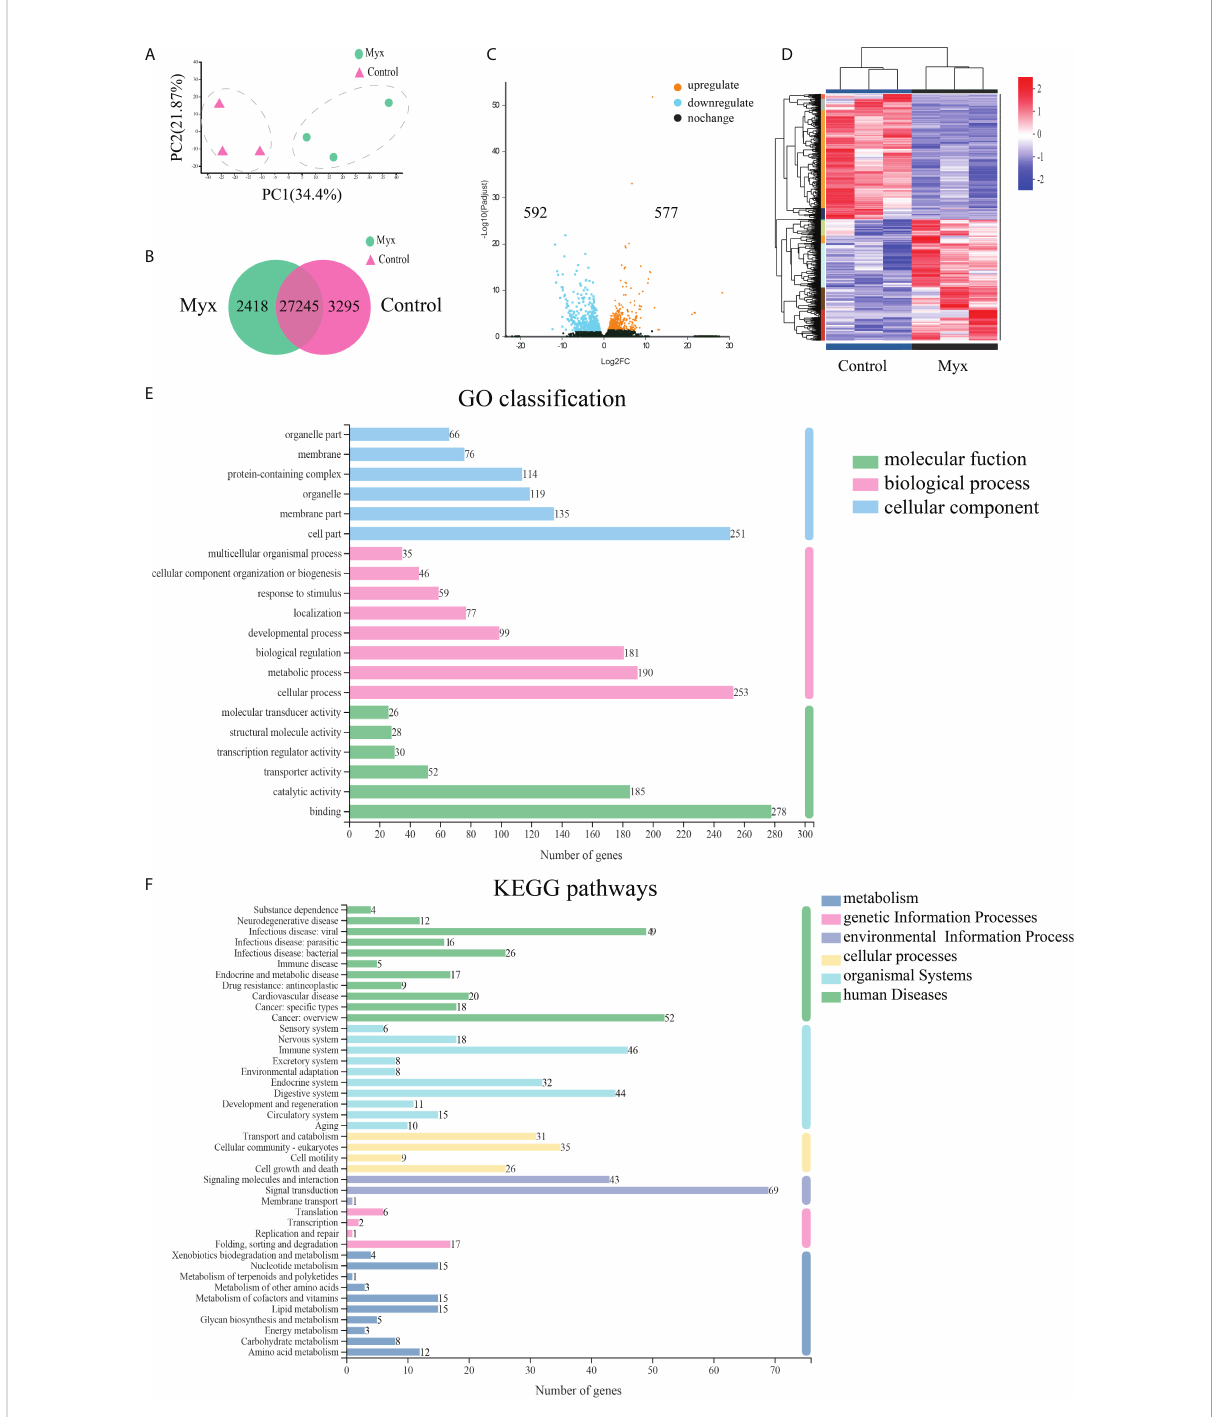
FIGURE 5 Effects of Myxobolus ampullicapsulatus -stimulation on the transcriptomic dynamic changes of gold fi sh gill and DEGs classi fi cation. (A) Principal component analysis (PCA) of the gill transcriptome in basal conditions and Myx-infected groups. (B) Venn diagram of DEGs among control and Myx groups. (C) Volcano plot displaying the DEGs distribution in two groups. (D) Hierarchical clustering analysis divided the individual samples of two groups based on FPKM of DEGs. Red and blue indicated that the gene expression level was up-regulation and down-regulation, respectively. (E) Histogram of GO annotation analysis. Bule bars, cellular component; pink bars, biological process; green bars, molecular function. (F) Histogram of KEGG annotation analysis. Green bars, human diseases; light bule bars, organismal systems; yellow bars, cellular processes; lavender bars, environmental information processing; pink bars, genetic information processing; deep blue bars,